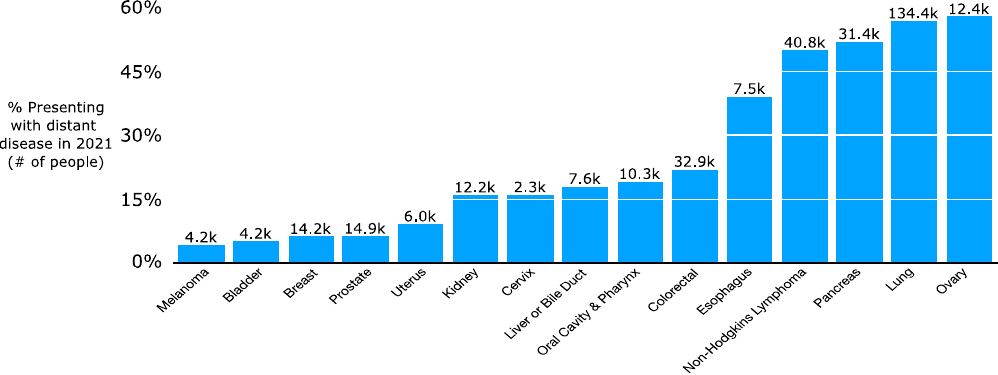
Figure 1. Proportion of patients presenting with upfront distant disease by cancer type in the period 2010–2016. Typically, the anti-cancer immune response is mediated, in part, by dendritic cells (DCs) presenting tumor neoantigens to T cells. To evade this response, tumors may impair